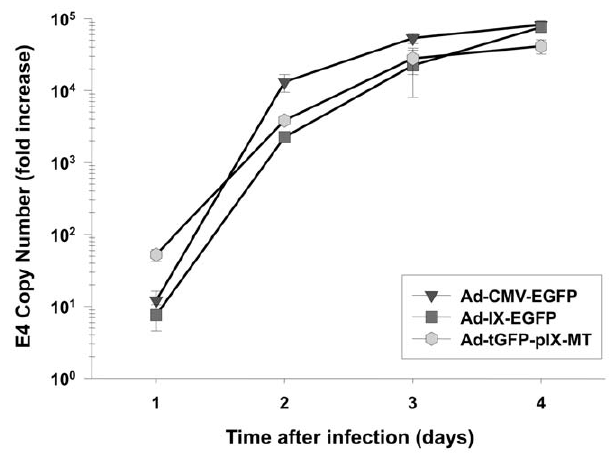
Figure 2. Replication of Ad-tGFP-pIX-MT compared to Ad-CMV- EGFP and Ad-IX-EGFP. Viral copy number was used as an indicator of viral replication in HEK293 cells. Growth medium was collected at 1, 2, 3, and 4 days after infection with Ad-tGFP-pIX-MT, Ad-CMV-EGFP, or Ad- IX-EGFP at an m.o.i. of 10 i.f.u/cell. Each point represents the mean 6 SE of three replicate samples.